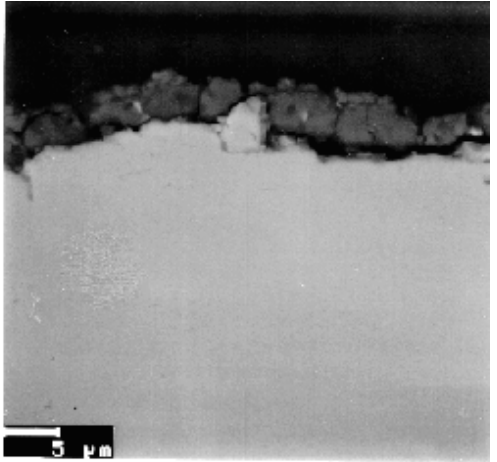
Figure 2. Cross-sectional morphology of NiAl after oxidation at 1100 °C for 490